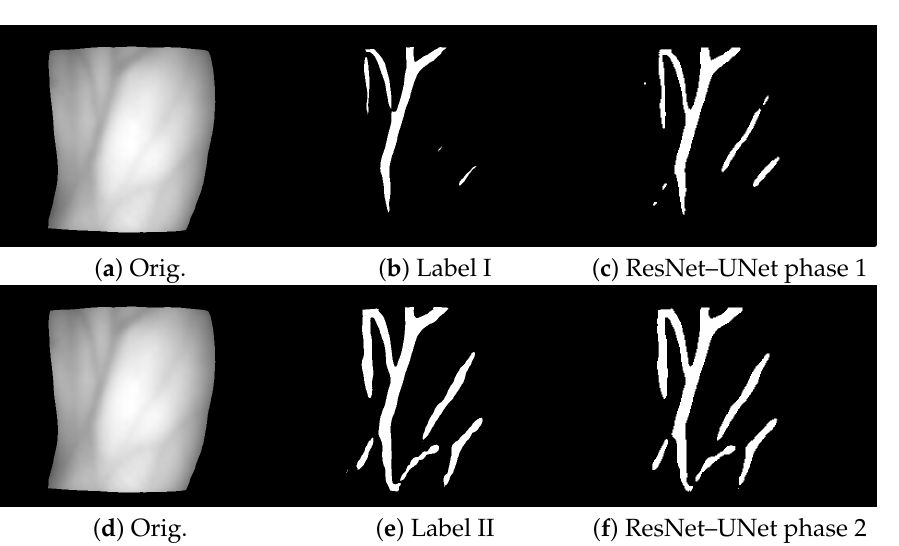
Figure 25. Visual comparison of the approach proposed: phase 1 and phase 2